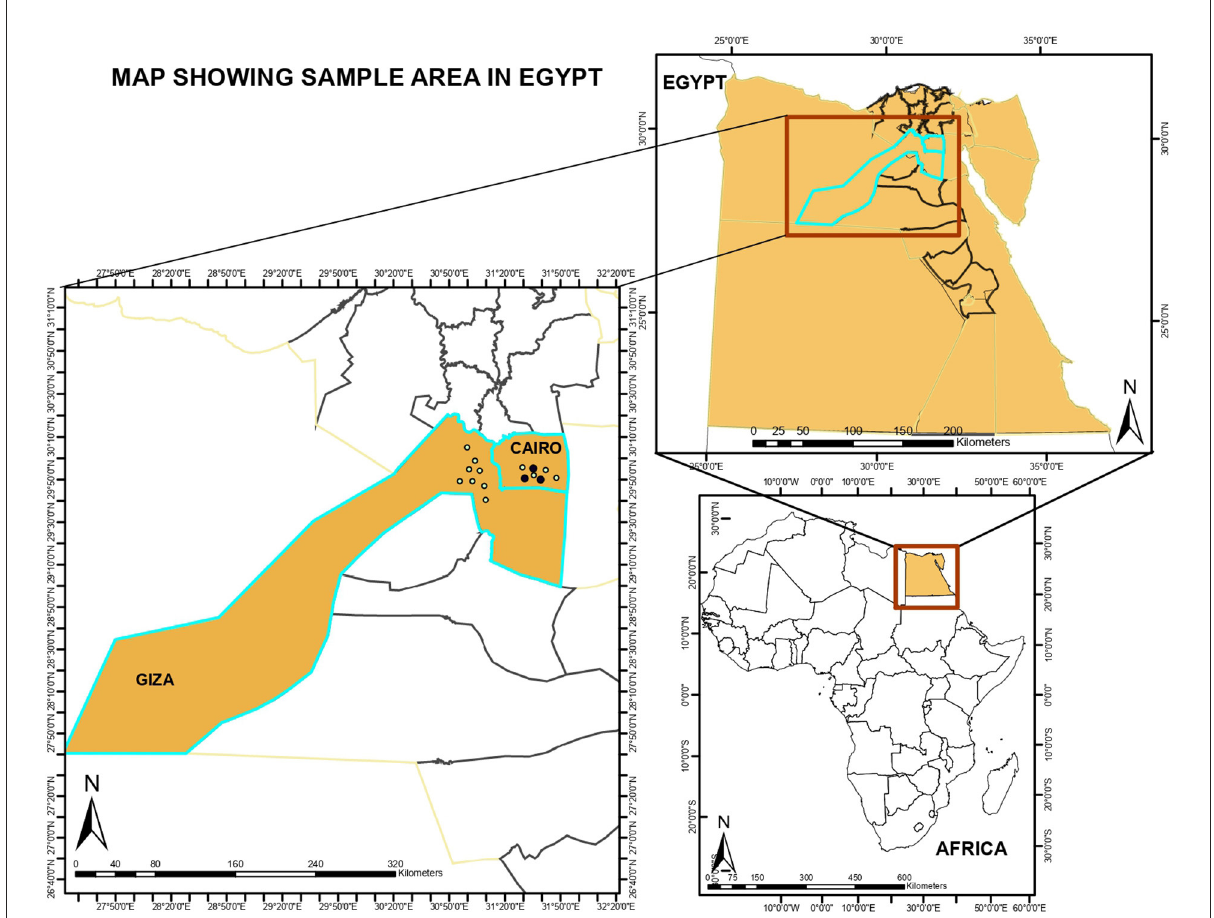
FIGURE1 Shape files of study locations were obtained from the ArcGIS online map tools and imported for visualization into ArcGIS version 10.8.1 Redlands, CA: Environmental Systems Research Institute, Inc.,